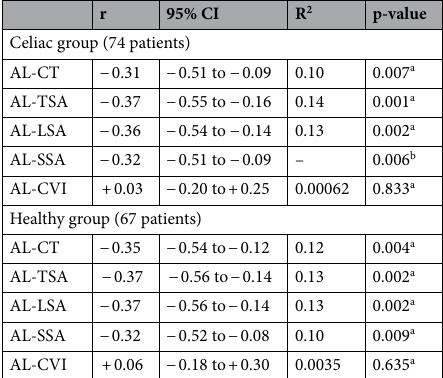
Table 2. Correlation between AL and the choroidal parameters in the two study groups. r correlation coefficient, 95% CI 95% confidence interval, R 2 determination coefficient, AL axial length, CT choroidal thickness, TSA total subfoveal area, LSA luminal subfoveal area, SSA stromal subfoveal area, CVI choroidal vascularity index. a Pearson correlation. b Spearman correlation.